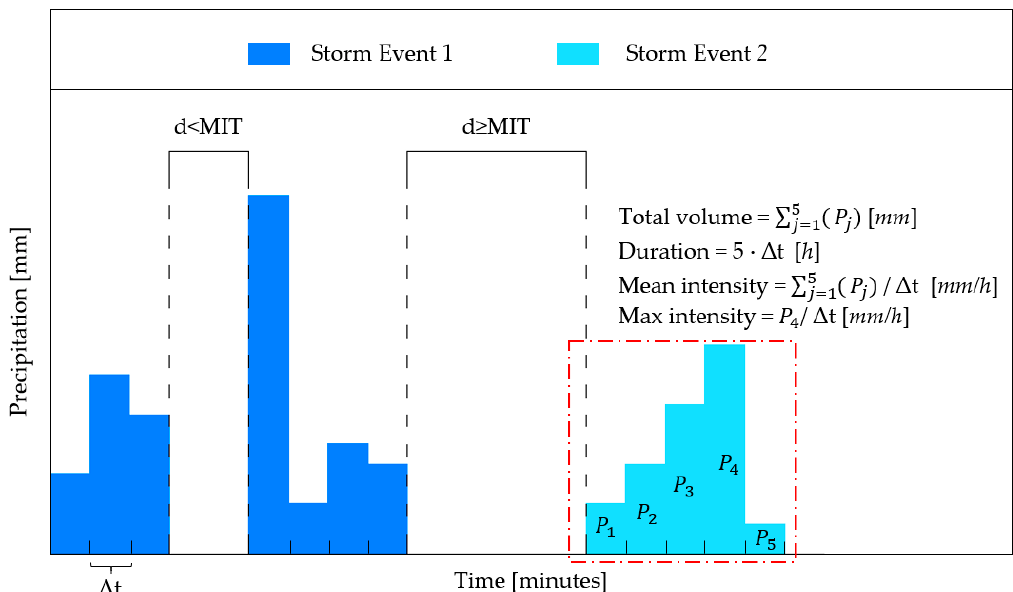
Figure 2. Identification of independent rainstorm events in a continuous rainfall series. As an example, the calculation of key characteristics of rainfall is showed for storm event 2, composed by five values of single rainfall impulse j .